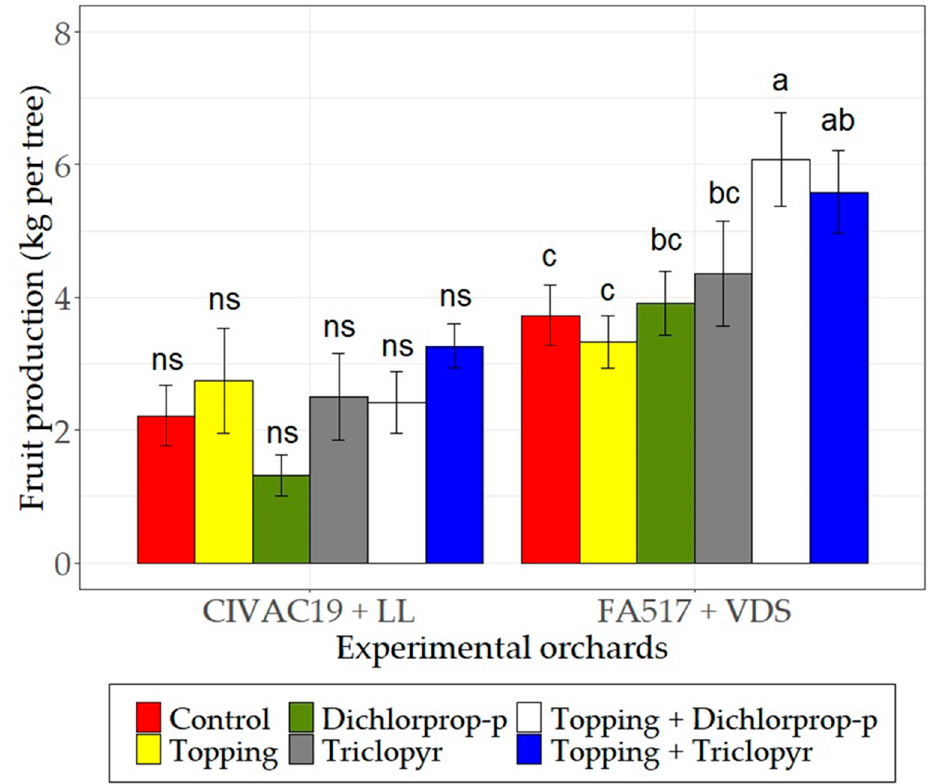
Figure 1. Fruit production ± standard error (SE) under the effect of six different treatments (control, topping, dichlorprop-p, triclopyr, topping + dichlorprop-p and topping + triclopyr) in the two experimental orchards with different rootstocks (CIVAC19 and Forner-Alcaide no. 517) and cultivars (‘Lane Late’ and ‘Valencia Delta Seedless’) from the 2020 harvest season. Values of columns with different letters were significantly different among treatments for each orchard according to LSD- Fisher test ( p < 0.05). LL: ‘Lane Late’, FA517: Forner-Alcaide no. 517, VDS: ‘Valencia Delta Seedless’, ns: not significant.